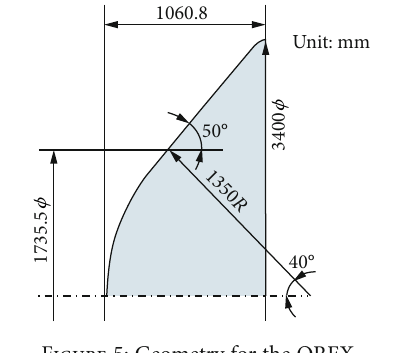
Figure 5: Geometry for the OREX.